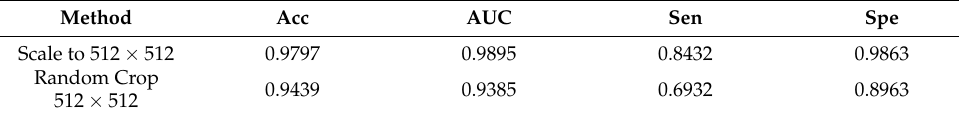
Table 8. The performance of different settings in the CHASEDB1